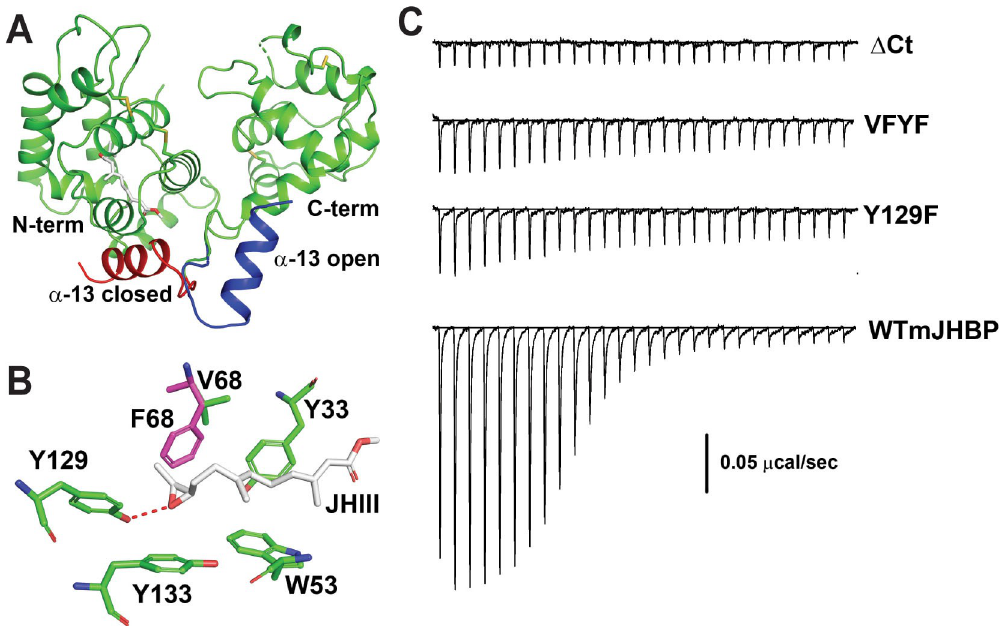
Fig 5. Mutagenesis and ligand binding profiling of mJHBP. A. The JH III binding site is located in the N-terminal domain (N-term). In the wild type mJHBP-JH III complex helix α -13 of the C-terminal domain covers the ligand access channel (red). The α -13 position in the presumed open form of the ligand-free protein would be folded back over the C-terminal domain (blue). In the Δ Ct mutant α -13 is missing, apparently destabilizing the mJHBP-JH III complex. B. Binding site detail showing hydrogen bonding between the Tyr129 hydroxyl group and the JH III epoxy group. This residue is mutated to phenylalanine in the Y129F and VFYF mutants. In the VFYF mutant Val68 is also mutated to phenylalanine (magenta), further occluding the binding pocket. C. Three site-directed mutants of mJHBP were evaluated for interaction with JH III using isothermal titration calorimetry (ITC). Traces showing heats of interaction reveal highly enthalpic binding of JH III with the WT protein. Injection heats decrease with increasing modification of the protein (WT > Y129F > VFYF > Δ Ct).